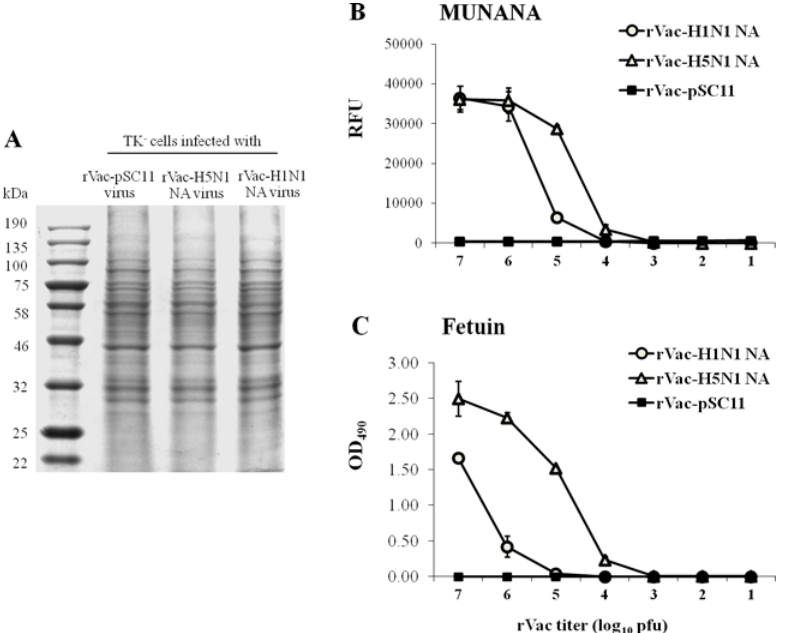
Fig 5. Neuraminidase enzymatic activity of NA proteins in lysates of TK − cells infected with recombinant vaccinia virus harboring H1N1 NA gene (rVac-H1N1 NA) or H5N1 NA gene (rVac-H5N1 NA). (A) SDS-PAGE and Coomassie blue staining demonstrate the comparable intensity of various protein bands (viral NA and cellular proteins) in TK − cells infected with rVac-pSC11, rVac-H5N1 NA or rVac-H1N1 NA virus. (B) Neuraminidase enzymatic activity of NA proteins in lysates of TK − cells infected with rVac-H1N1 NA or rVac-H5N1 NA virus as determined by MUNANA-based assay; and (C) fetuin-based ELLA. The cleavage product of MUNANA substrate is measured in term of RFU; and that of fetuin substrate is measured as the OD values. The H5N1 NA protein is statistically higher in sialidase activity than H1N1 NA protein (ANOVA, p < 0.001). Enzymatic activity is not found in lysate of TK − cells infected with rVac-pSC11